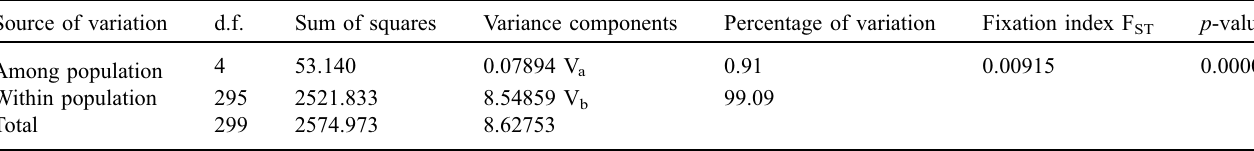
Table 1. AMOVA results of fi ve Larimichthys polyactis populations.